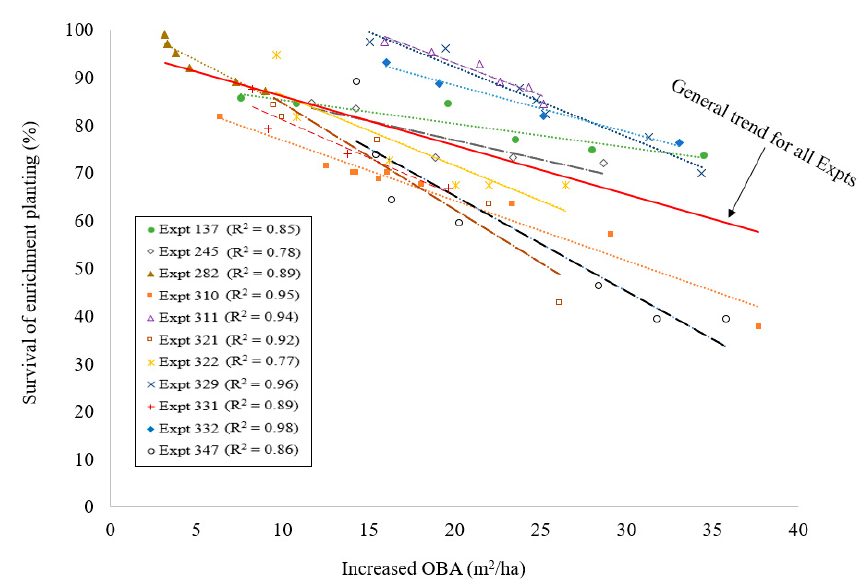
Figure 3. The effect of growth of overwood basal area (OBA) over time on the survival of enrichment plantings (experiments 322 and 245 had a p -value < 0.05, all other experiments had a p -value < 0.01). Table 2. Initial overwood basal area and the survival of enrichment plantings at the age of their first measurement.